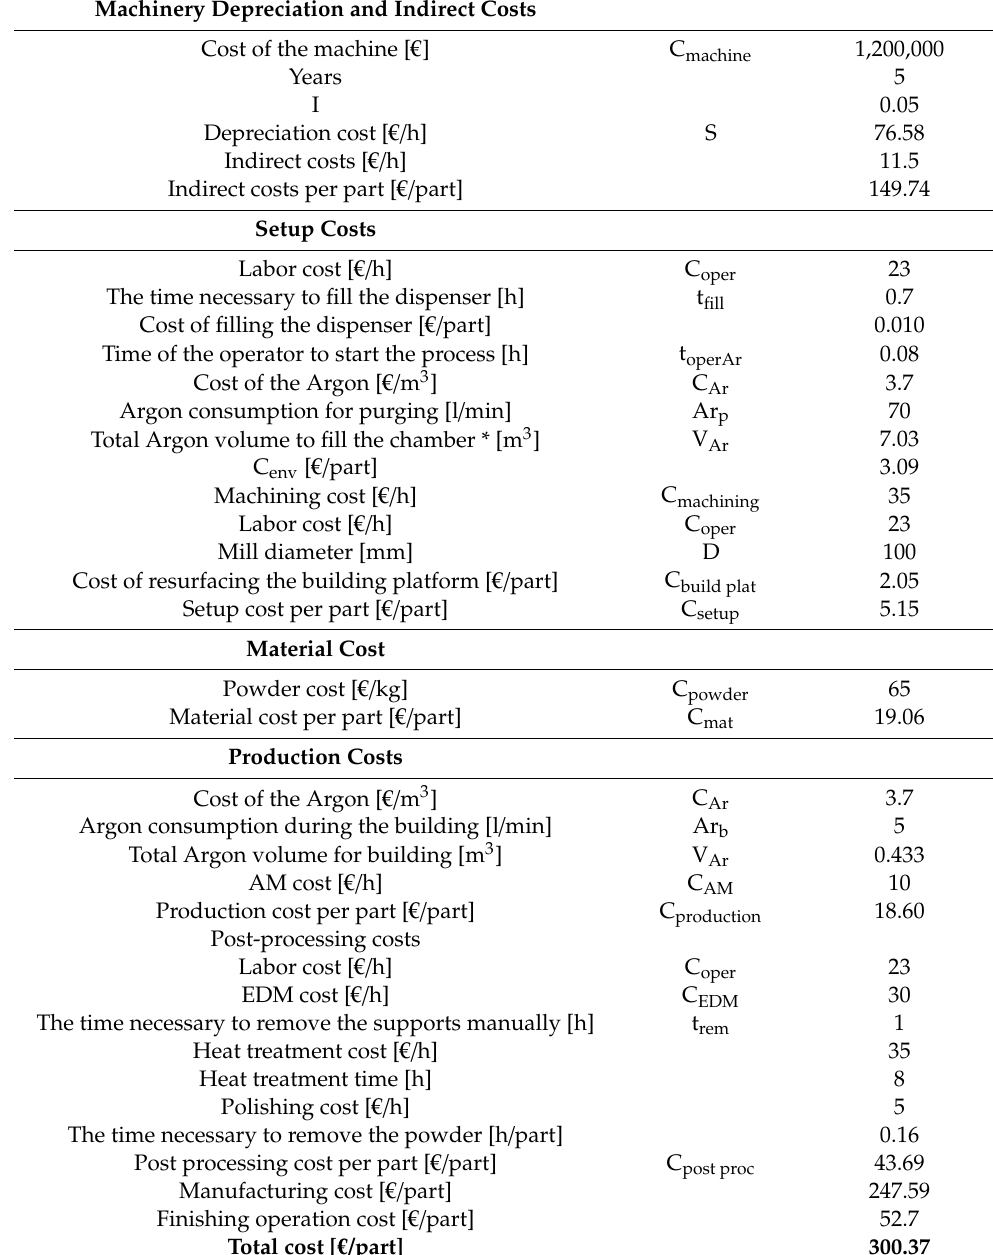
Table 4. Calculation of the total manufacturing costs according to the model presented in Section 4.1. * The volume of Argon necessary to fill the chamber, V Ar , is the product of t fillAr and Ar p